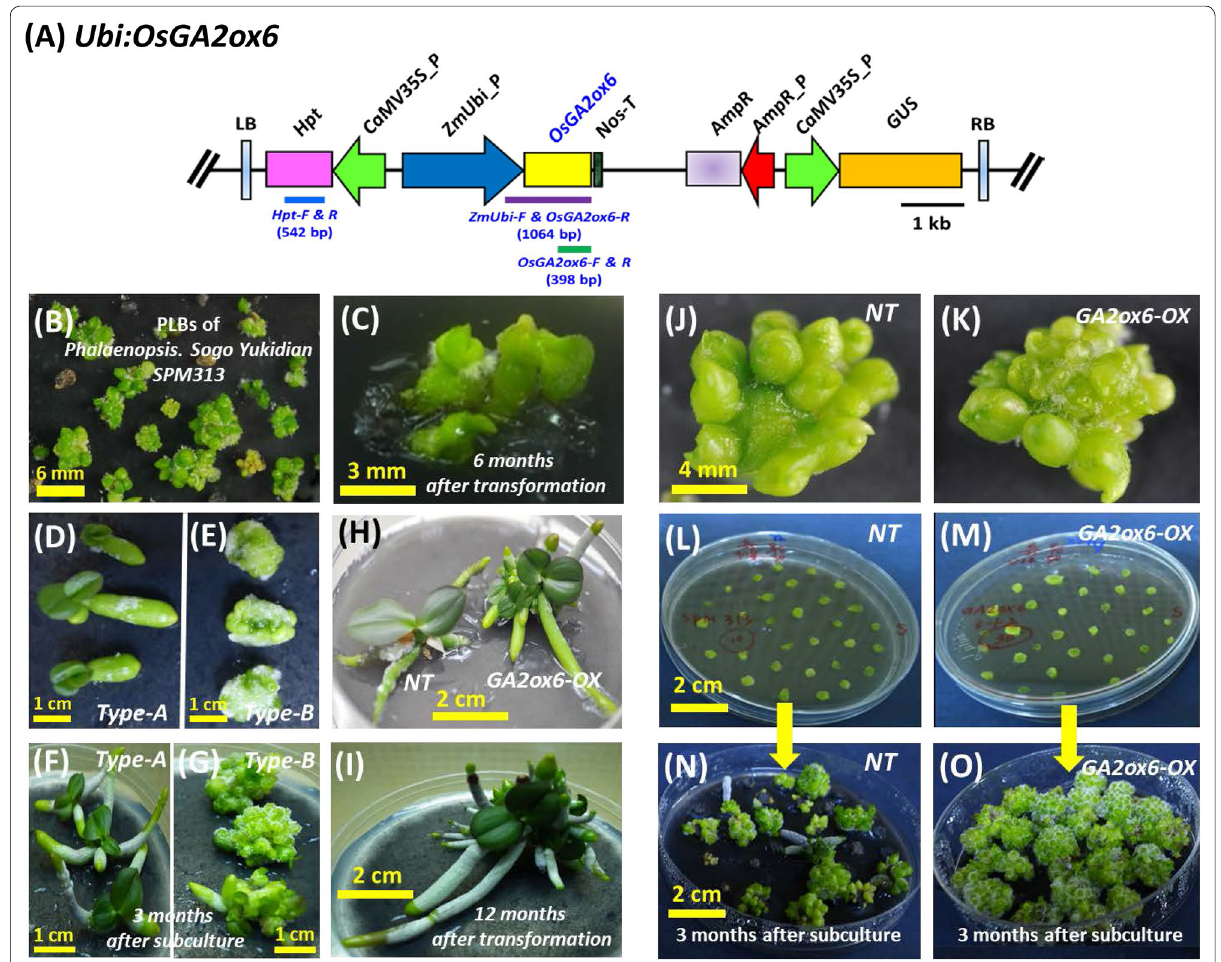
Fig. 1 Ubi:OsGA2ox6 transformation vector and comparisons of different propagation types of GA2ox6 ‑ OX transgenic lines at various growth stages. a Schematic diagram of the Ubi:OsGA2ox6 transformation vector. The target gene OsGA2ox6 (yellow box) driven by the ZmUbi promoter (blue arrow), hygromycin phosphotransferase ( Hpt ) and GUS genes driven by the 35S promoter (green arrows) in their relative scale within the left border (LB) and right border (RB) of T‑DNA are shown. The primers ( Hpt ‑ F & ‑ R and ZmUbi ‑ F & OsGA2ox6 ‑ R ) used for confirming vector integration (genomic DNA PCR) and the primers ( OsGA2ox6 ‑ F & ‑ R ) used for gene expression analysis (RT‑PCR) as well as the sizes in bp of their PCR products are indicated. b Protocorm‑like bodies (PLBs) of Phalaenopsis Sogo Yukidian ‘ SPM313’ used for transformation. c Three surviving transgenic PLBs 6 months after transformation and selection. d–g Growth of propagation type A ( d , f ) and type B ( e , g ) from the GA2ox6 ‑ OX transgenic line 1 month ( d , e ) and 3 months (F, G) after subculture. A group of three PLBs is shown. h Examples of an NT (left) and a GA2ox6 ‑ OX transgenic (right) plantlet growing multiple leaves and roots approximately 10 months after transformation. i Close‑up view of a transgenic plantlet growing approximately 12 months after transformation. j – k Example of the mother PLBs from NT ( j ) and GA2ox6 ‑ OX transgenic ( k ) lines used for propagation. l – m Clonal propagation of NT and GA2ox6 ‑ OX transgenic PLBs compared in parallel. The PLBs from NT ( l ) and GA2ox6 ‑ OX ( m ) lines were dissected horizontally to expose their surrounding epidermal cells in order to generate and propagate new PLBs. n – o Growth of many PLBs three months after subculture for NT ( n ) and GA2ox6 ‑ OX ( o )